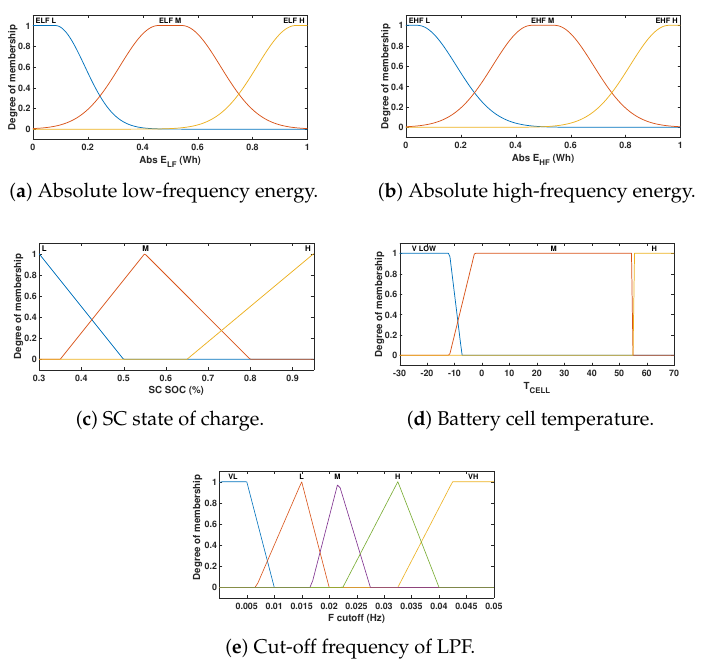
conditions), and creates an optimum cut-off frequency for the low-pass filter to ensure an effective power-sharing strategy. In EVs, the load current continuously varies. Fuzzy logic works to split the combined power P C between the battery and SC while changing the cut-off frequencies. The fuzzy system consists of four inputs and one output parameter: the low-frequency absolute energy ( Abs E LF ), high-frequency absolute energy ( Abs E HF ), SC state of charge ( SC SOC ), battery cell temperature ( T C ) and the cut-off frequency ( F CUTOFF ), respectively. Further, the above fuzzy parameters are defined into three membership functions: Low, Medium, and High, as shown in Figure 7.